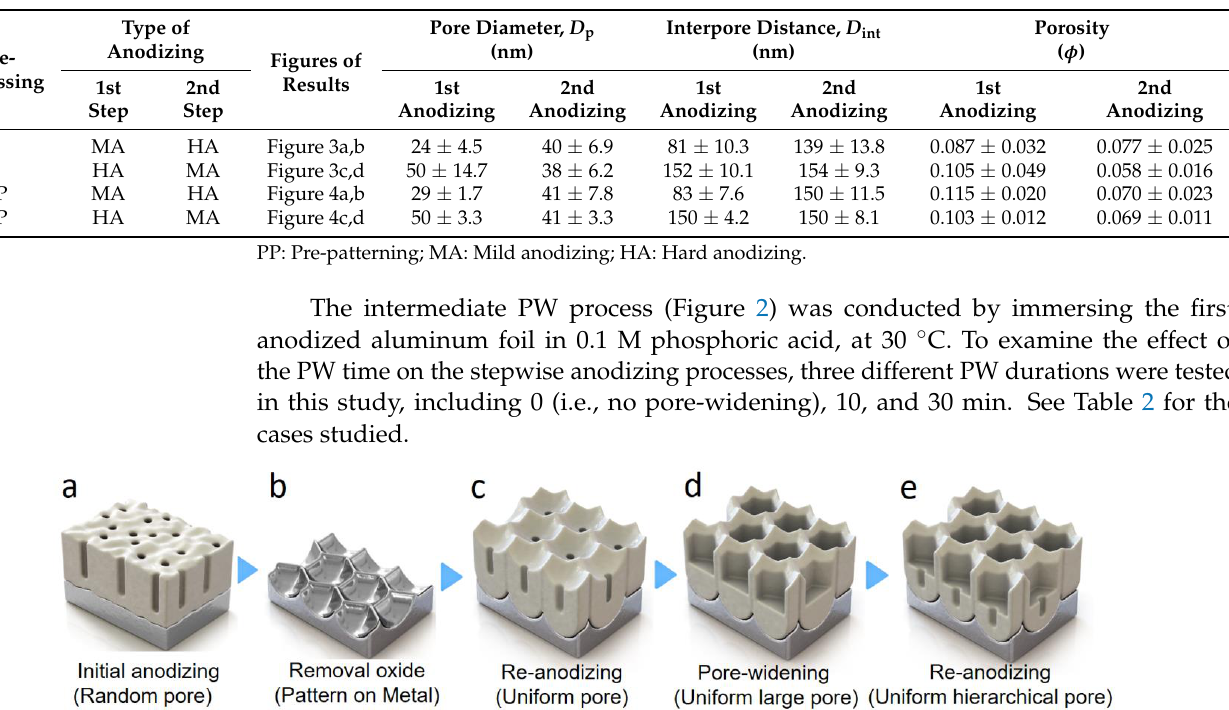
Table 1. Stepwise anodizing conditions and the structural dimensions of the anodized nanoporous alumina with no intermediate pore-widening step.